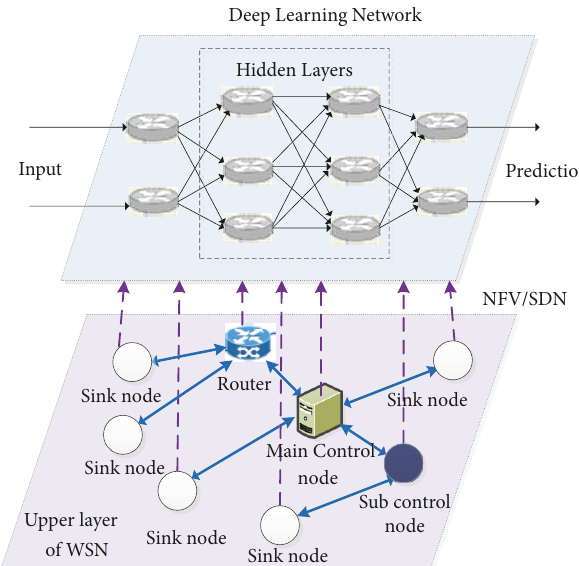
Figure 2: Deep learning network structure in